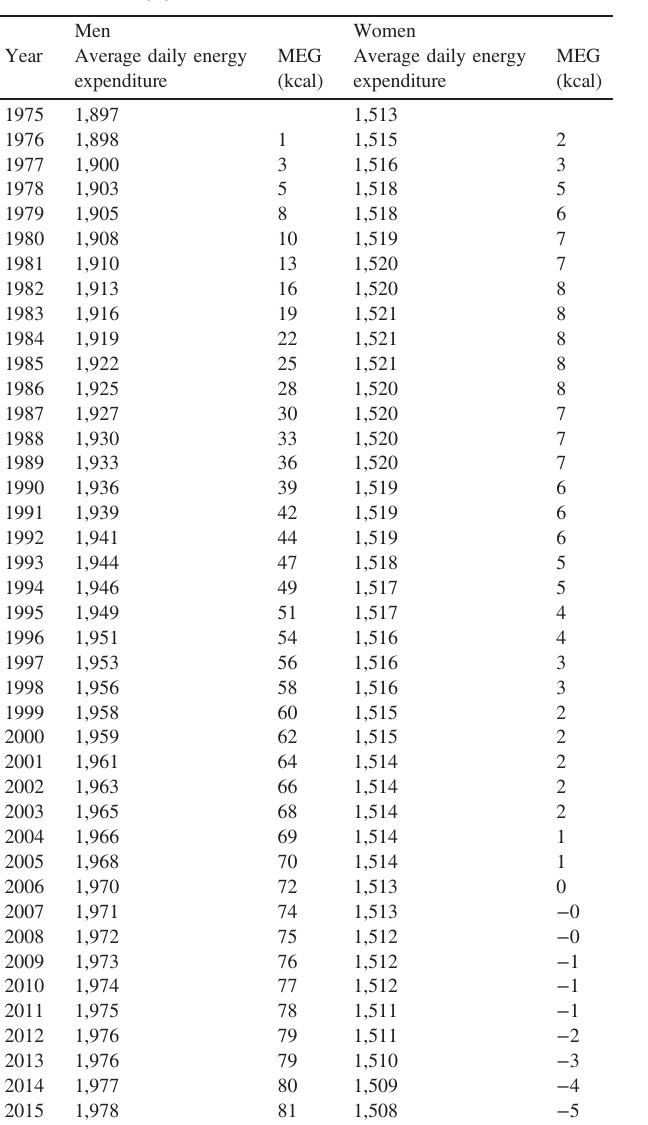
a Test statistic > Critical value.